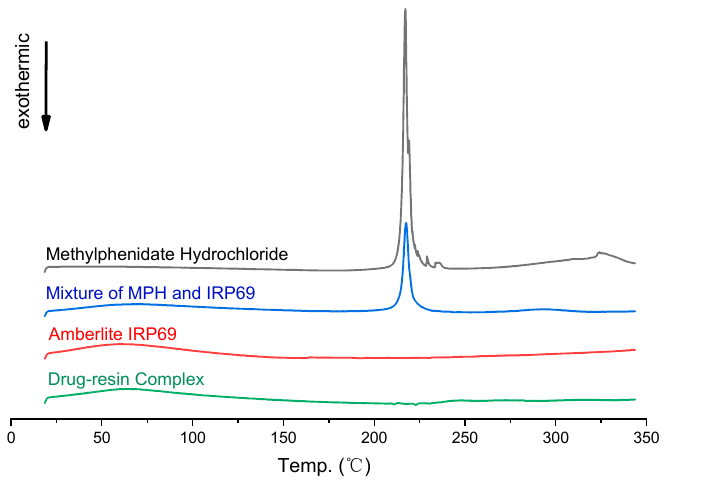
Figure 3. DSC patterns of methylphenidate hydrochloride, Amberlite IRP69, a mixture of methylphenidate hydrochloride and Amberlite IRP69, and drug–resin complex. As shown in Figure 4., the XRD pattern of a mixture of methylphenidate hydrochloride and Amberlite IRP69 exhibited sharp peaks at 2 θ of about 8.3°, 10.5°, 14.6°, 15.2°, 19.5°, 20.8°, 23°, 25.1°, 26° and 31.1°, in accord with the pattern of methylphenidate hydrochloride [27]. However, the drug–resin complex displayed no reflection peaks indicating the absence of crystalline methylphenidate hydrochloride. The results coincided exactly with DSC studies, reflecting that methylphenidate was mostly another form instead of a crystalline structure in the drug–resin complex systems.